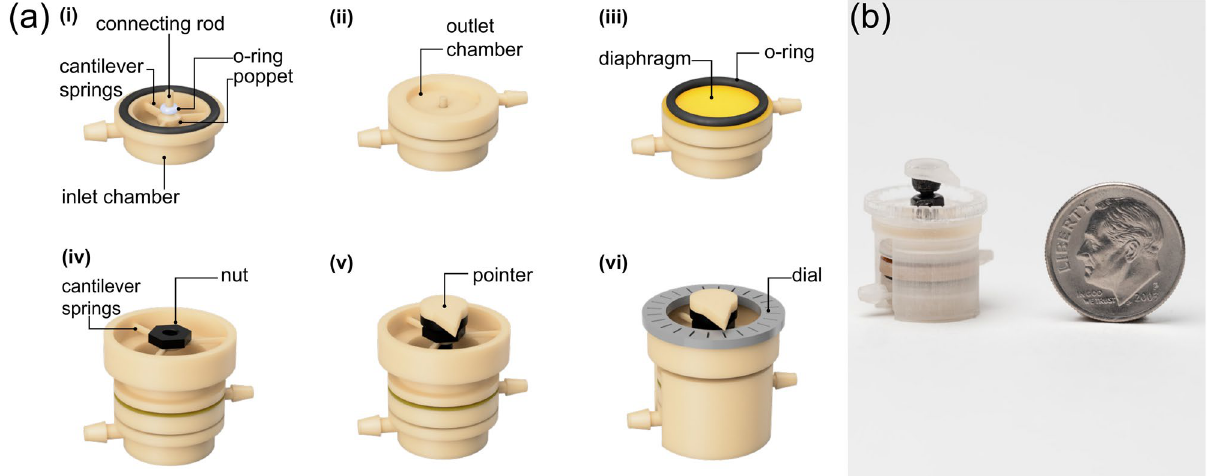
Figure 1. ( a ) Schematic view of the 3D printed µPR and fabrication workflow. (i) The high-pressure air inlet chamber includes a poppet valve, a sealing O-ring (white), and a connecting rod. (ii) The low-pressure air chamber is placed on top of the inlet chamber. (iii) A Kapton diaphragm (yellow) and O-ring (black) are placed atop the outlet chamber. (iv) The pressure control component, consisting of three built-in cantilevers and a threaded nut, is positioned on top of the O-ring. (v) An M2 bolt with a 3D-printed position indication pointer is threaded into the nut. (vi) The device is then sealed using two 3D-printed compression clamps to achieve an air-tight assembly (Φ12 mm × 20 mm) and a laser-cut position dial is added. ( b ) Image of the assembled 3D-printed µPR next to a United States dime for